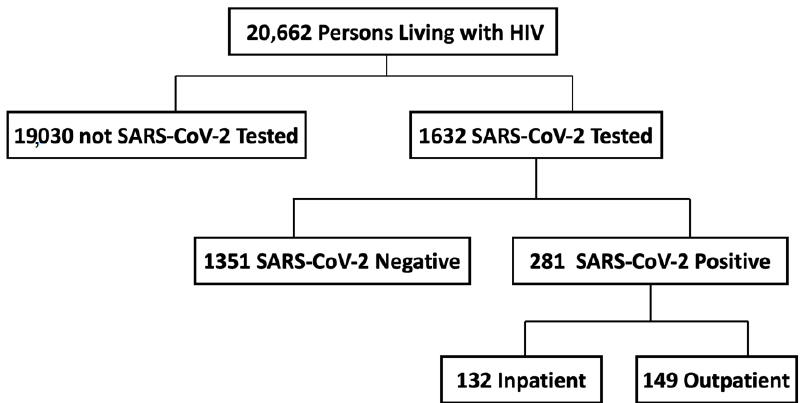
Figure 1. PLWH seen in the MedStar healthcare system with and without SARS-CoV-2 Testing. Flow chart of persons living with HIV seen in the MedStar Healthcare system. Abbreviations: HIV, Human Immunodeficiency Virus; PLWH, Persons Living with HIV; SARS-CoV-2, Severe Acute Respiratory Syndrome Coronavirus 2.